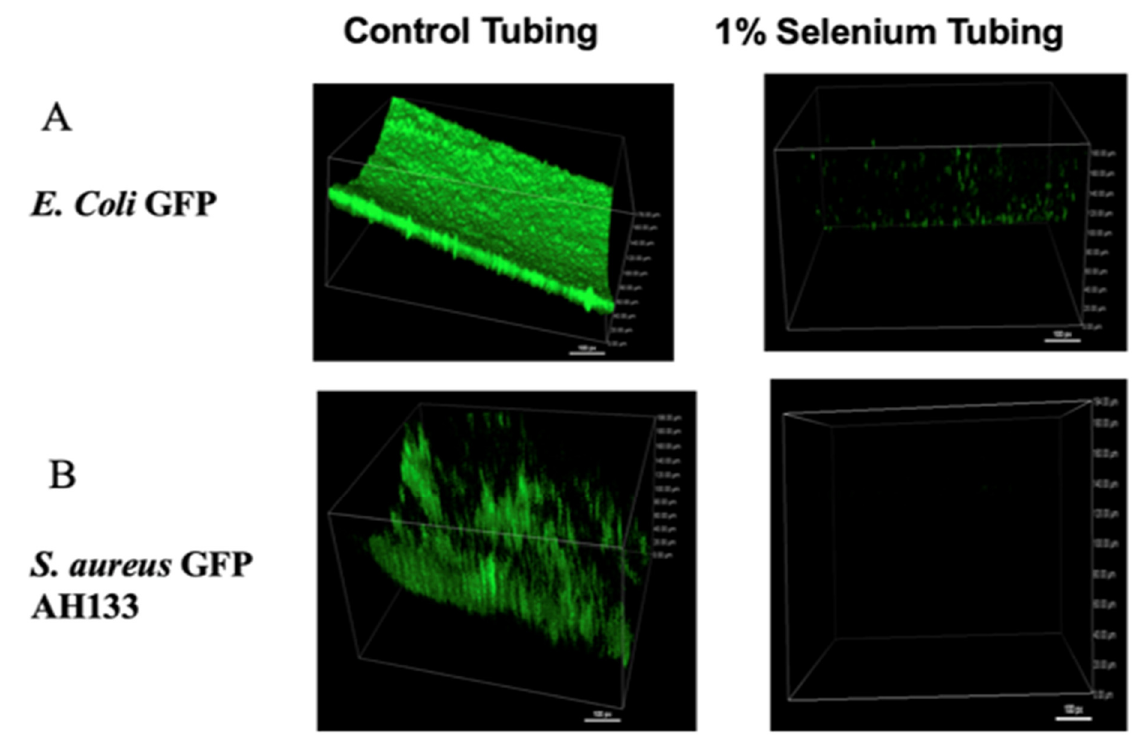
Figure 1. Confocal laser scanning microscopy of biofilm formed by E. coli GFP ( A ) and S. aureus GFP AH133 ( B ) on control tubing (left) and selenium compound polymerized tubing (right). Images were acquired at 2 µm intervals through the biofilms using a Nikon A1+/AIR+ Confocal Microscope.